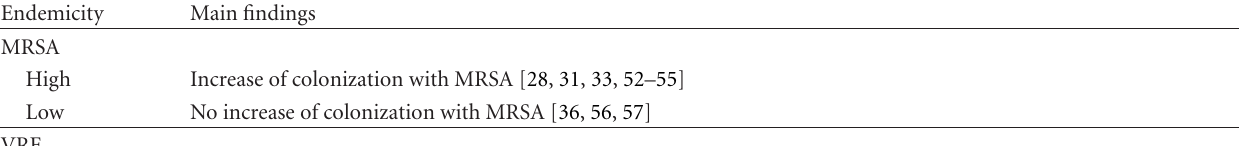
Table 4: SDD and the emergence of antimicrobial resistance, in areas with high and low endemicity.